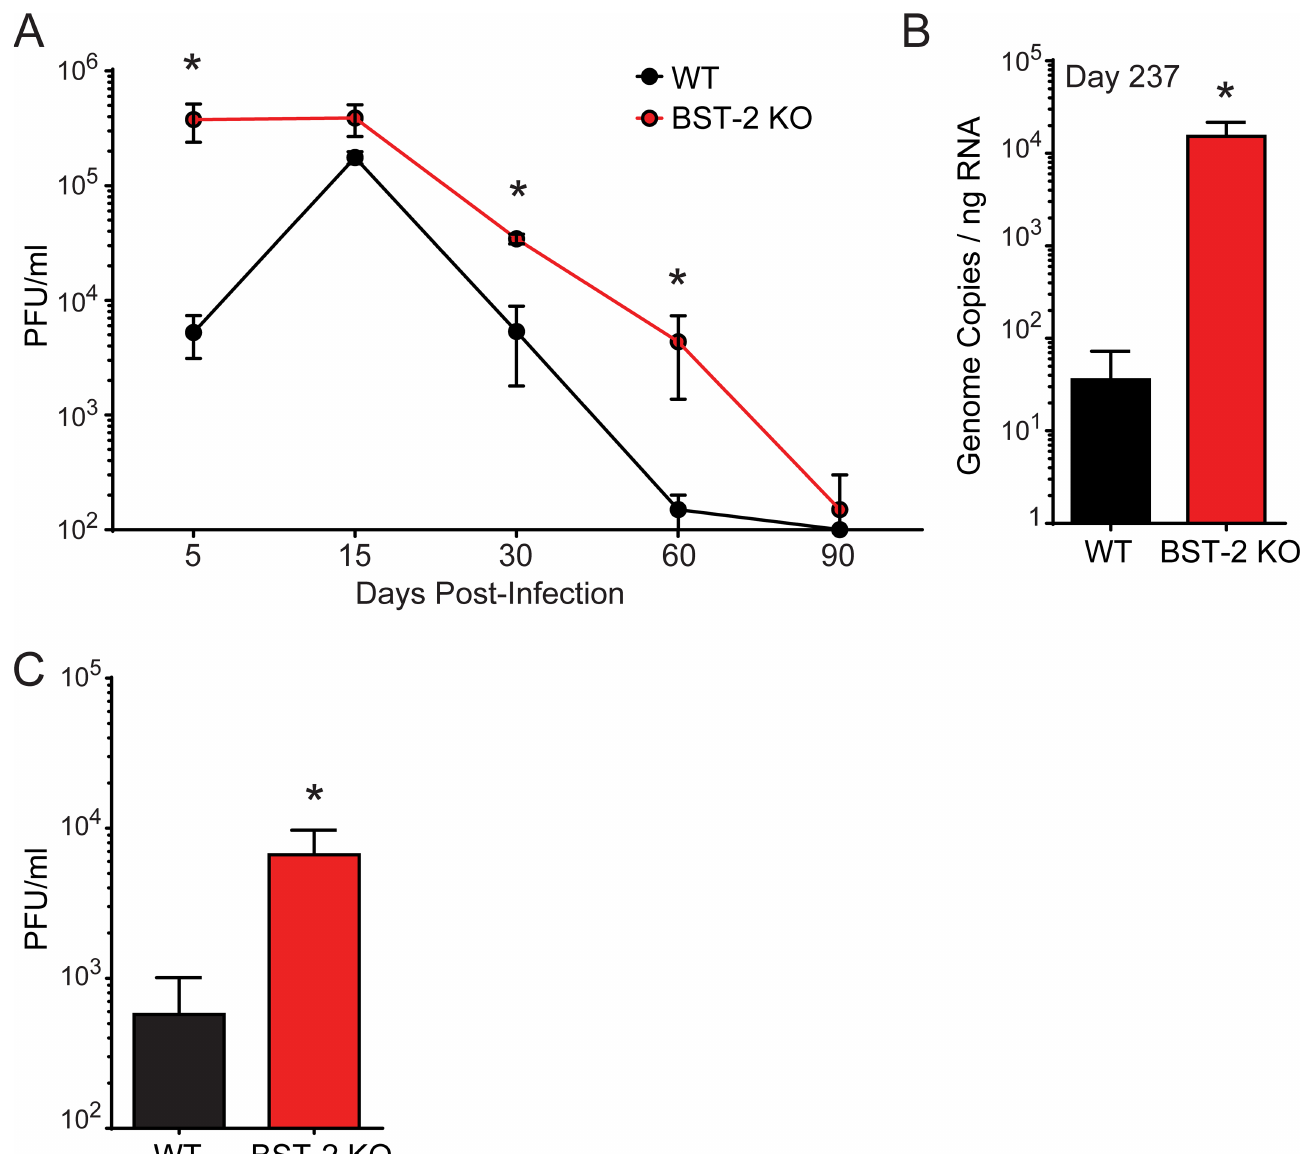
Fig 7. BST-2 deficiency impedes control of acute and persistent strains of LCMV. A. Serum viral titers were quantified by plaque assay in WT vs. BST-2 KO mice infected with LCMV Cl-13 (n = 5 mice per group; 2 independent experiments). B. Brain viral loads were quantified by Q-PCR [48] in WT vs. BST-2 KO mice 237 days following infection with LCMV Cl-13 (n = 3–4 mice per group; 2 independent experiments). C. Serum viral titers were quantified by plaque assay in WT vs. BST-2 KO mice 5 days following infection with LCMV Arm (n = 3–4 mice per group; 2 independent experiments). All data in this figure are represented as mean ± SD. Asterisks denote statistical significance ( (cid:3) P <